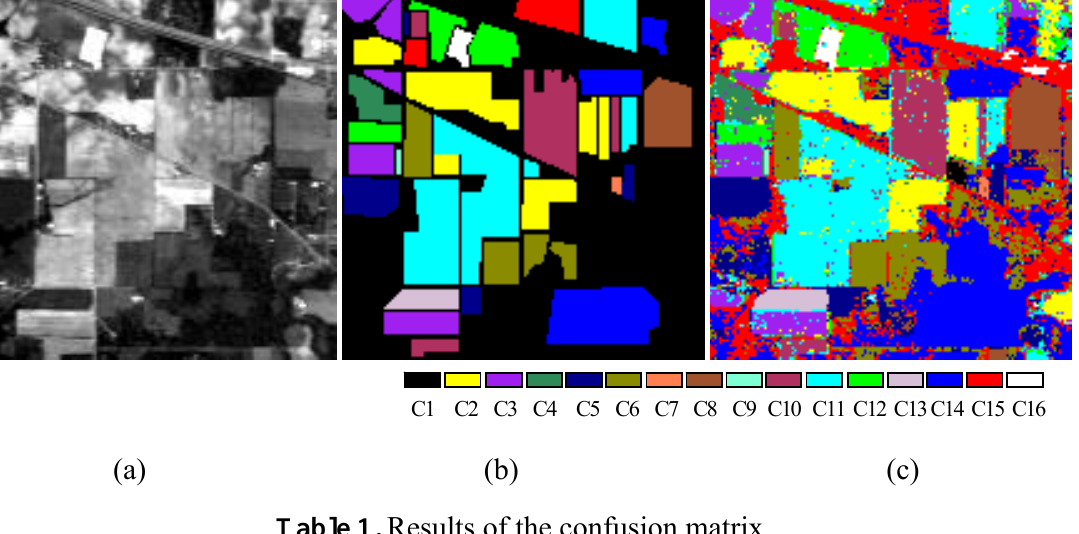
Figure 7. (a) Band 16 (central wavelength: 547.60 nm) of the AVIRIS Indian Pines data set and (b) ground truth. (c) Classification map obtained with the fixed subspace method combined with the [0, 1] normalization method. The subspace dimension was 7 and both learning parameters were 0.54. The overall classification accuracy was 91.79%.